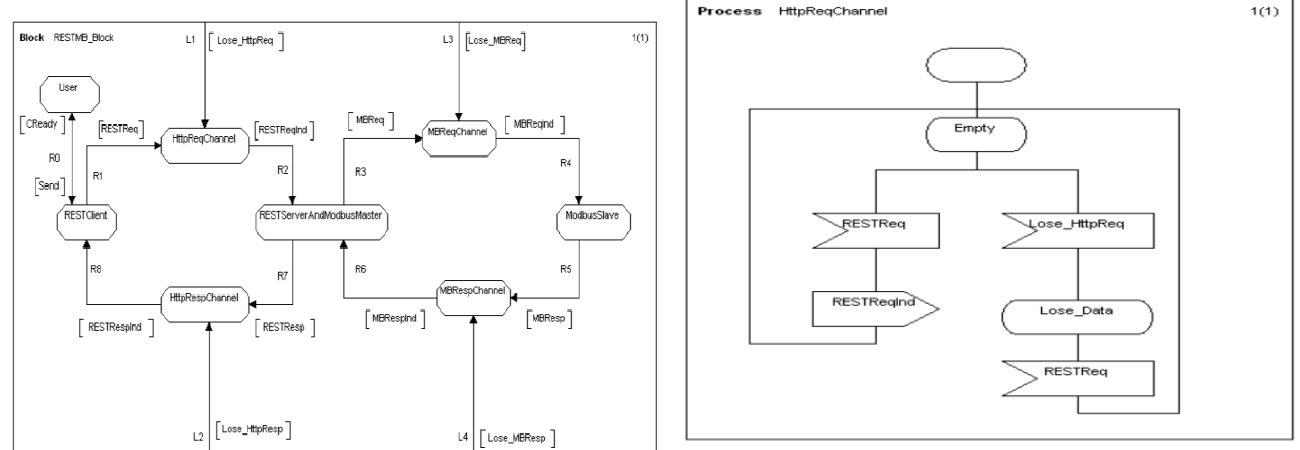
Figure 7: RestClient Process